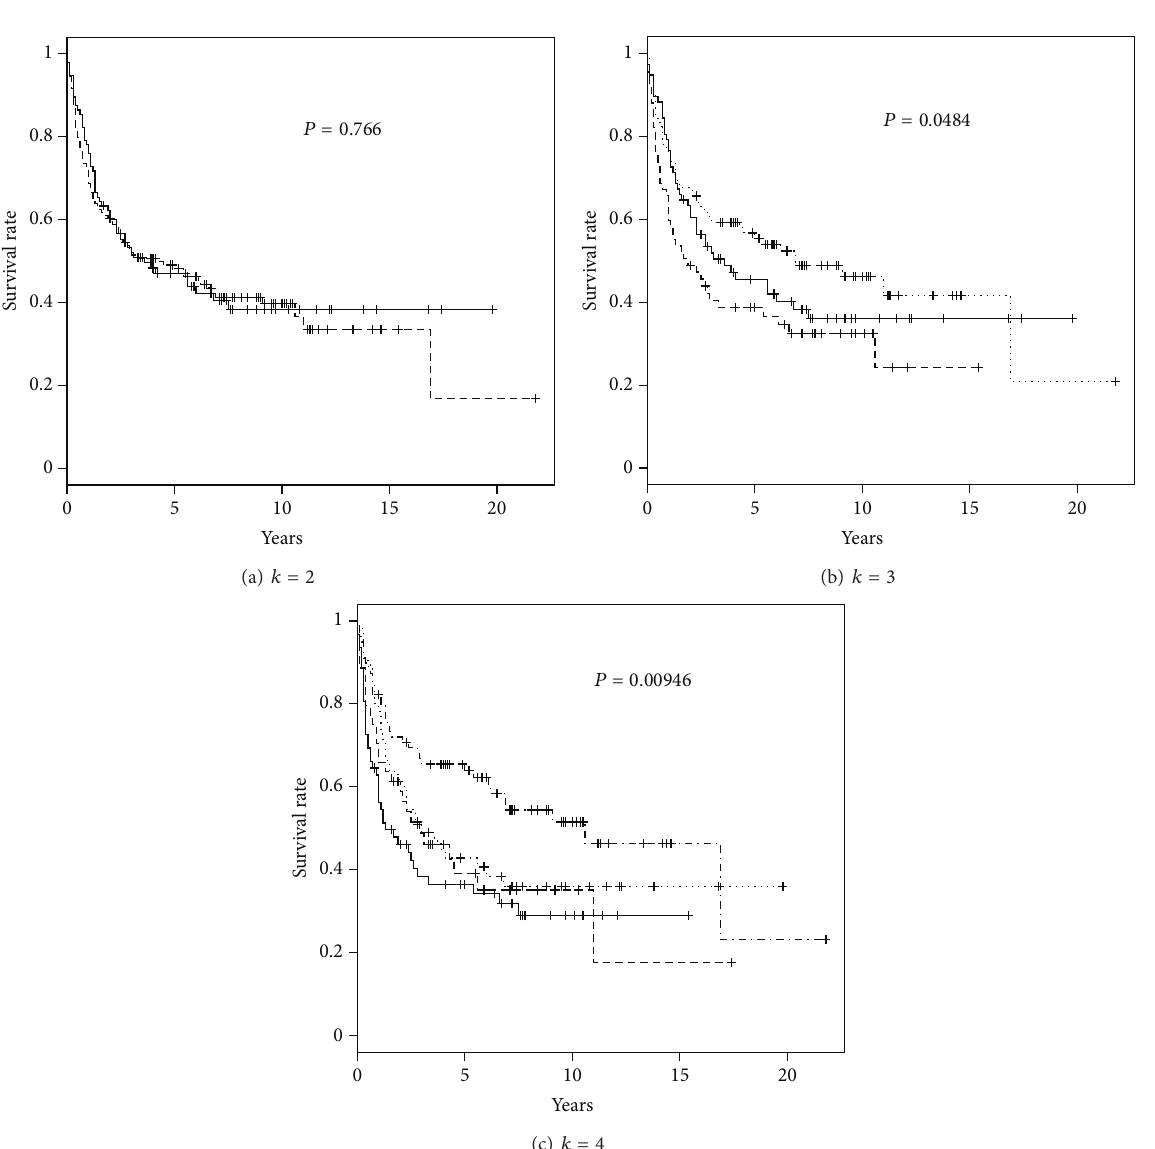
median the patient is assigned to the low-risk group. We can compare the results of 𝐿 1 - (lasso), 𝐿 2 - (ridge), and 𝐿 1 - 𝐿 2 combined (elastic net) penalized regression model by the Kaplan-Meier